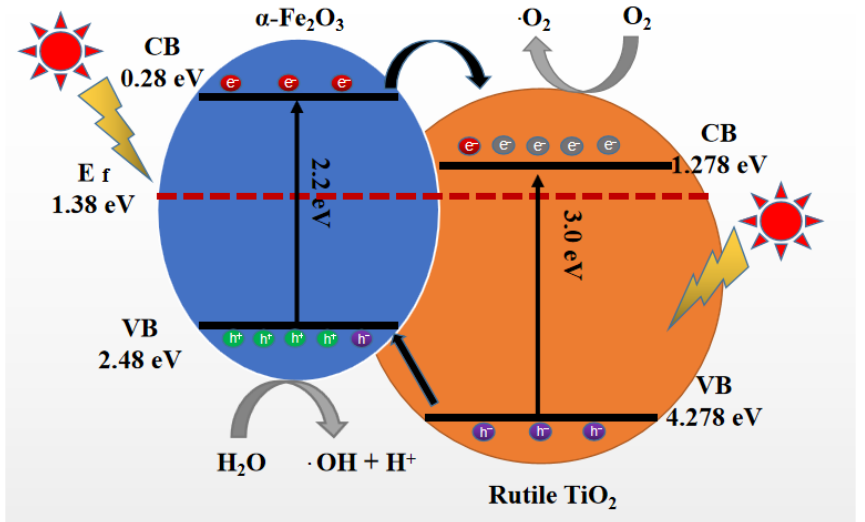
Figure 11. Schematic diagrams of the photocatalytic mechanism of α -Fe 2 O 3